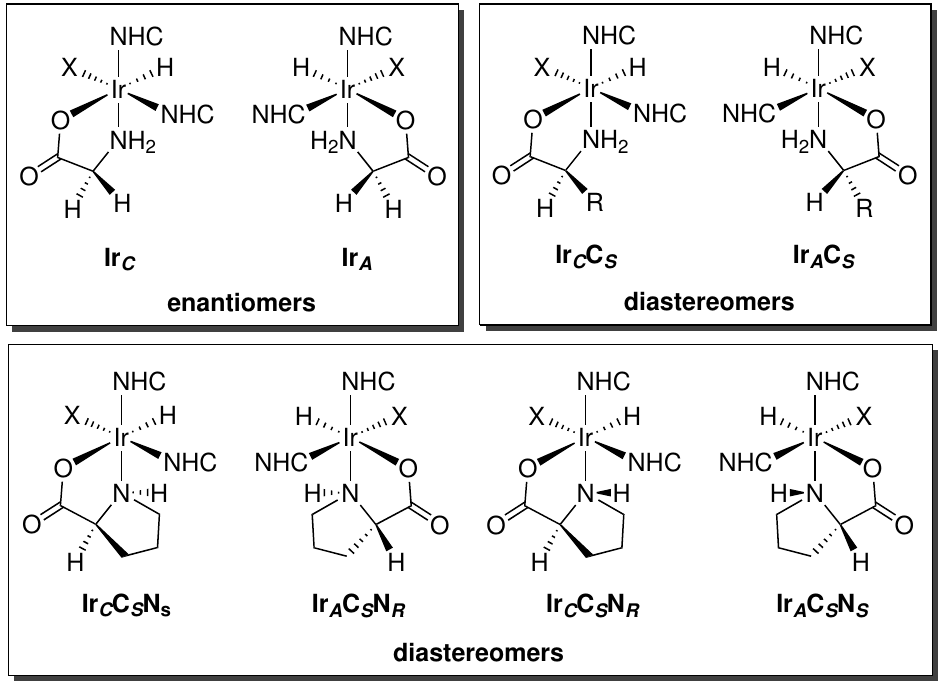
Figure 6. Upon oxidative addition, two metal enantiomers are formed when glycine is used ( top-left ). Employing a homochiral primary amino acid gives rise to a pair of metal diastereomers ( top-right ), while incorporation of a secondary amino acid such as L -proline gives rise to four possible metal diastereomers ( bottom